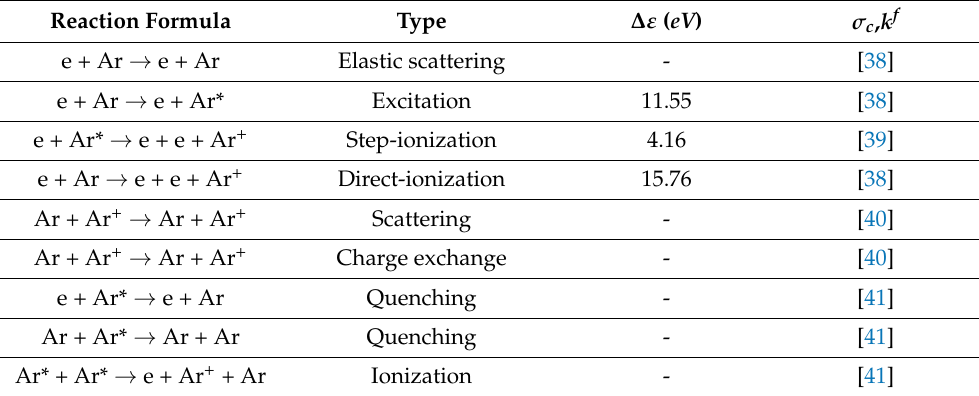
Table 1. Selected reaction for Argon discharges ( ∆ ε : threshold energy, σ c : cross-section, k f : rate coefficient (m 3 /s))